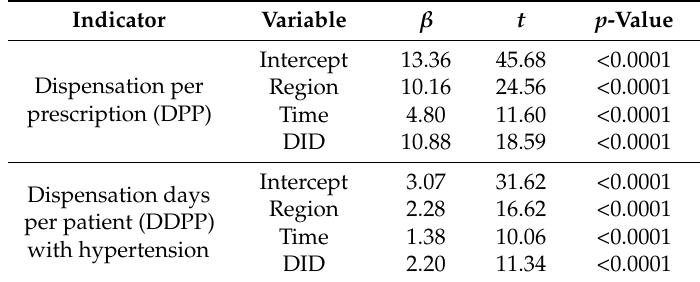
Table 4. The result of difference-in-difference regression analysis using the indicators for medication adherence to patients with